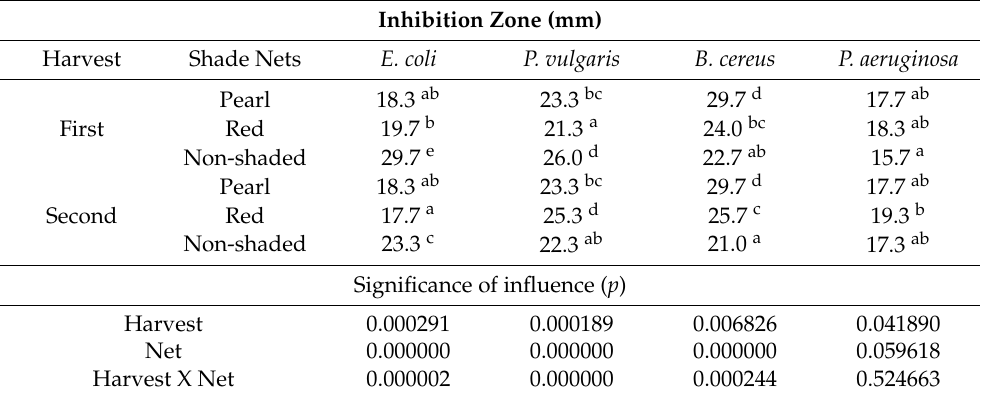
Table 4. Influence of harvest time and shading with pearl, red, and blue nets on antimicrobial activity of BEOs.